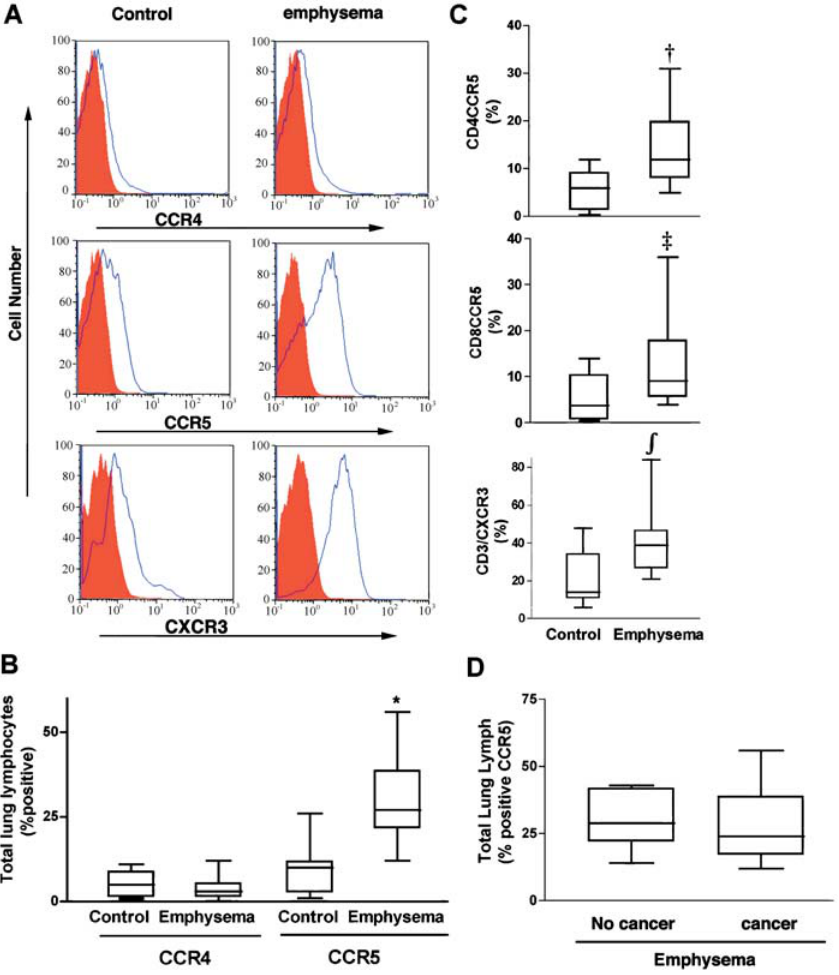
Figure 1. Chemokine Receptor Expression on Peripheral Lung Lymphocytes (A) Single color histograms showing expression of chemokine receptors CCR4, CCR5, and CXCR3 from representative control and emphysema participants. (B) Pooled data from all participants (control, n = 10; emphysema, n = 18) showing percent (median 6 SD) of total lung lymphocytes expressing CCR4 and CCR5. (C) Pooled data from same participants showing percent (median 6 SD) CCR5 expression on CD4 (top) and CD8 (middle) T cells, and CXCR3 expression on unfractionated T cells (bottom) from the same participant groups. (D) Analysis of total lung lymphocyte chemokine receptor (median 6 SD) profiles among participants with emphysema. Participants had either (1) lung volume reduction surgery for emphysema (non-cancer, n = 8) or (2) lung resection for treatment of small peripheral cancer ( n =